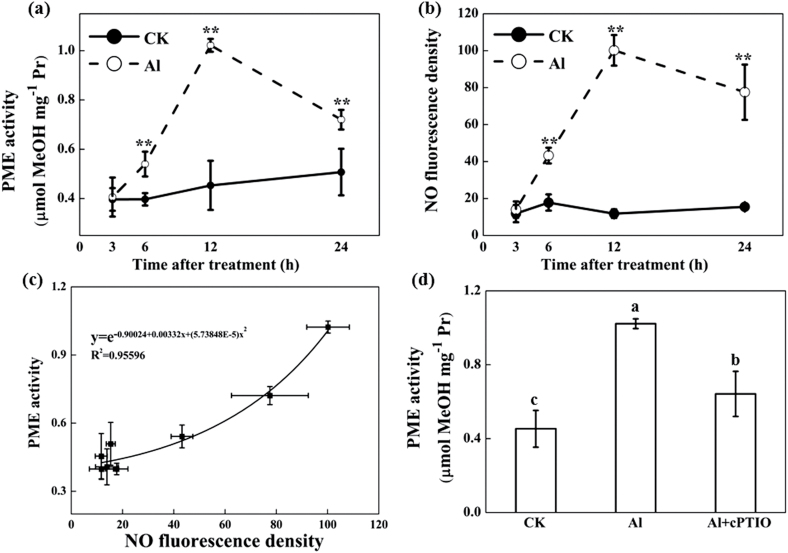
Effect of Al and cPTIO on PME activity and NO content in 10-mm root apices. Three-day-old wheat seedlings were treated with 0.5mM CaCl2 solution containing 0 or 30 μM Al with or without 30 μM cPTIO. PME activity (a), NO production (b), and the relationship between NO production and PME activity (c) after 3, 6, 12, and 24h treatment with or without Al. (d) PME activity after 24h treatment with and without Al and cPTIO. For quantification of NO production, root tips were loaded with 10 μM DAF-FM DA in 20mM HEPES-NaOH buffer (pH 7.4) and NO fluorescence was imaged after 20min. Images were analysed with Image-J and NO production was expressed as root fluorescence density. Means ± SD (n = 10). ** in (a) and (b) indicate significant difference between Al and control treatments at P < 0.01.